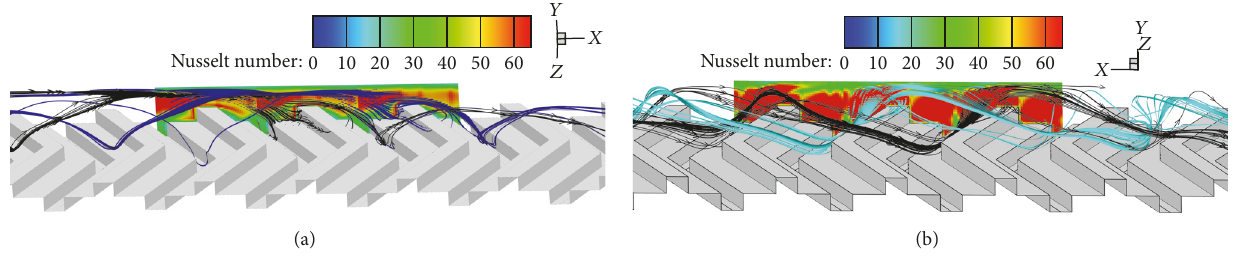
Figure 7: Impinging jet on the channel wall of the square channel heat exchanger inserted with 45 ∘ V-wavy plate at Re = 3000 for (a) V- Downstream and (b) V-Upstream.